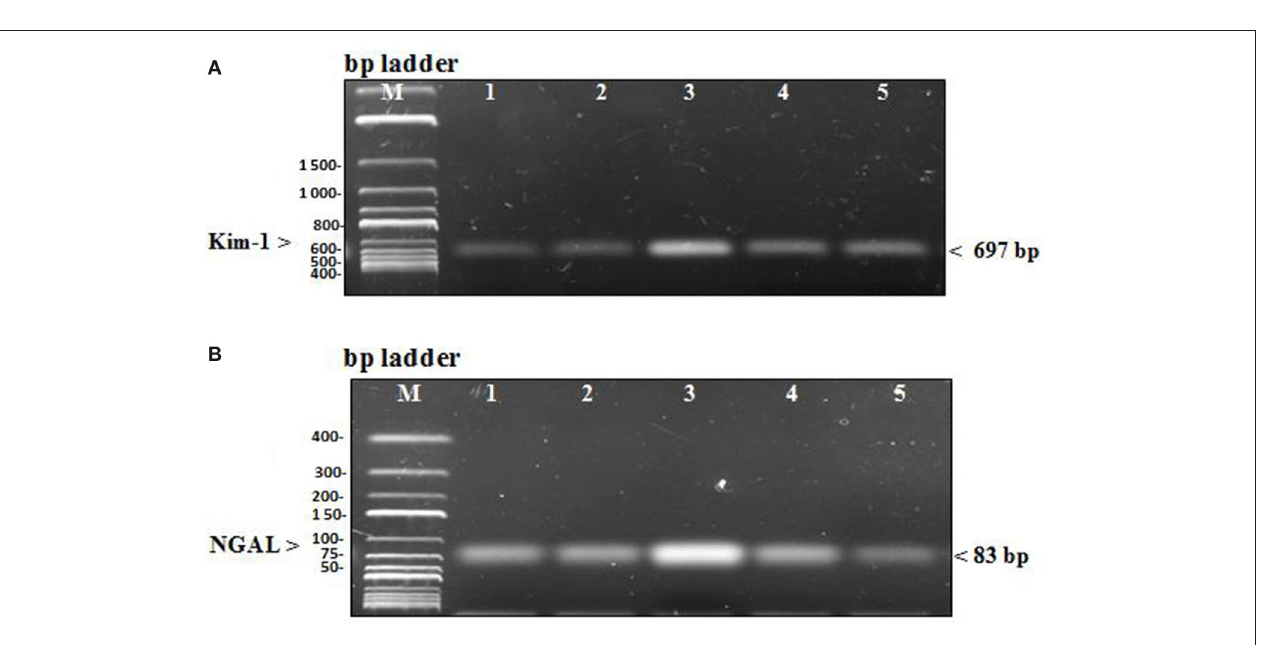
FIGURE 6 | ( A ) PCR products of renal injury mRNA biomarker Kim-1 were separated from kidney tissue of rats on agarose gel electrophoresis ( B ) PCR products of renal injury mRNA biomarker NGAL were separated from kidney tissue of rats on agarose gel electrophoresis. In each figure, Lane M: DNA molecular mass marker, lane 1 and 2: PCR products of Kim & NGAL gene expression in the control group that received no treatment and the stem cell group that received only HUCB MNCs, lane 3: PCR products of Kim & NGAL gene expression in the diseased group receiving GM only, lane 4 and 5: PCR products of Kim & NGAL gene expression in the preventive group that received HUCB MNCs before injecting with GM and the treated group that obtained GM injections followed by HUCB MNCs. As demonstrated, renal injury biomarker expression was significantly higher in the diseased group than in the other studied